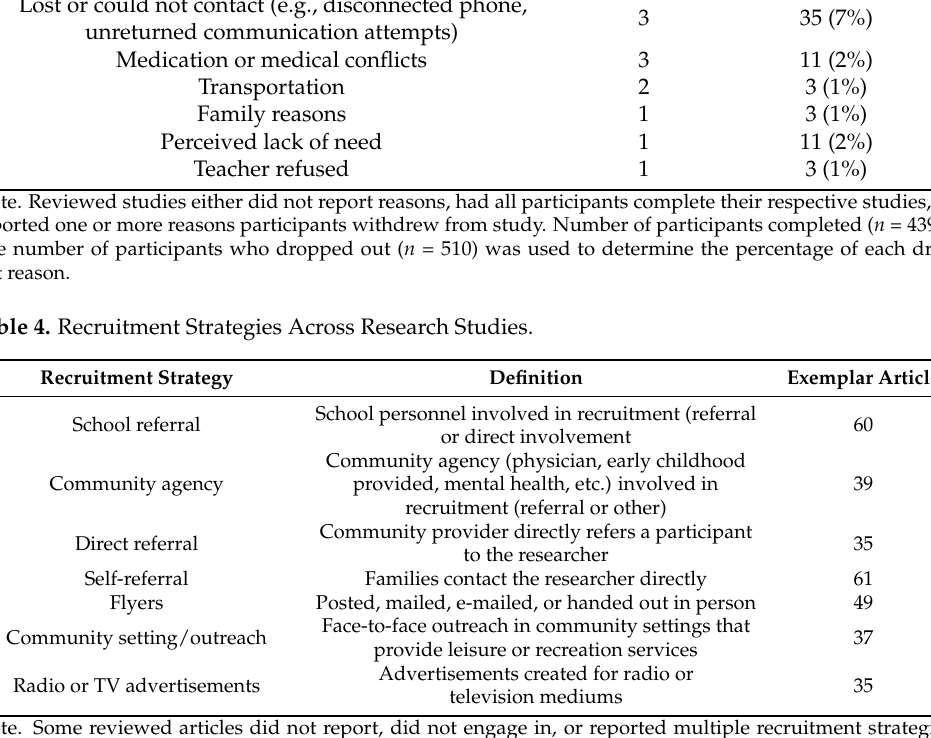
Table 3. Reported Reasons for Drop-out or Disconnection Across Studies. Reason Study n Participant n Not reported